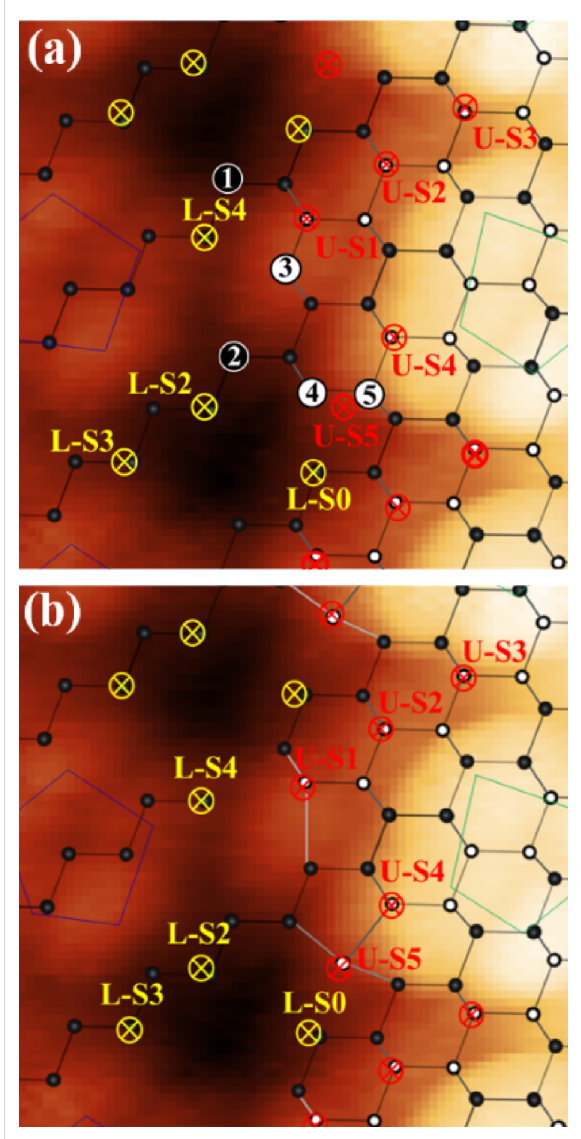
Figure 4: (a) An AFM image of the 16×2 reconstruction with the atomic lattice of the unreconstructed surface containing atomic steps. The rows of Si atoms in the first and second layers are indicated by white and black circles, respectively. Red and yellow crossmarks indicate the dangling bonds observed in AFM images on the upper terrace and lower terrace, respectively. Some atoms are labelled as 1 to 5 for clari- fication. (b) The atomic model with atoms 1, 3, and 4 removed from